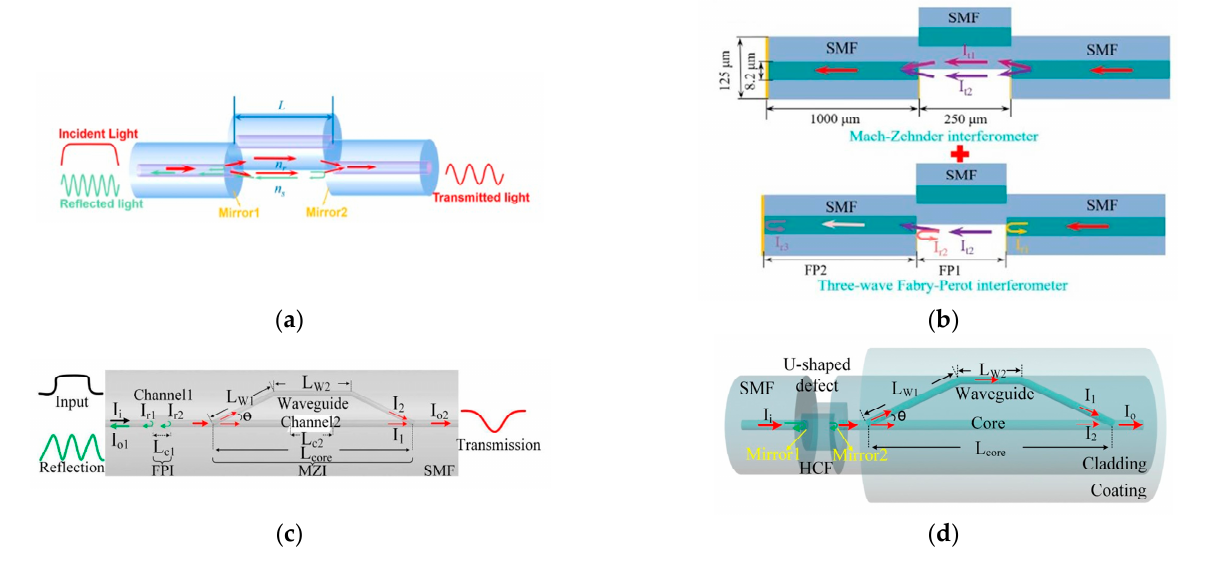
Figure 9. ( a ) Diagram of the proposed sensing structure [84]. ( b ) Light transmission path in the proposed sensing structure [85]. ( c ) Schematic of the proposed sensor [86]. ( d ) Diagram of the cascaded sensing structure [87]. Reprinted with permission from Ref. [84] © The Optical Society. Table 6. Summary of hybrid FPIs.